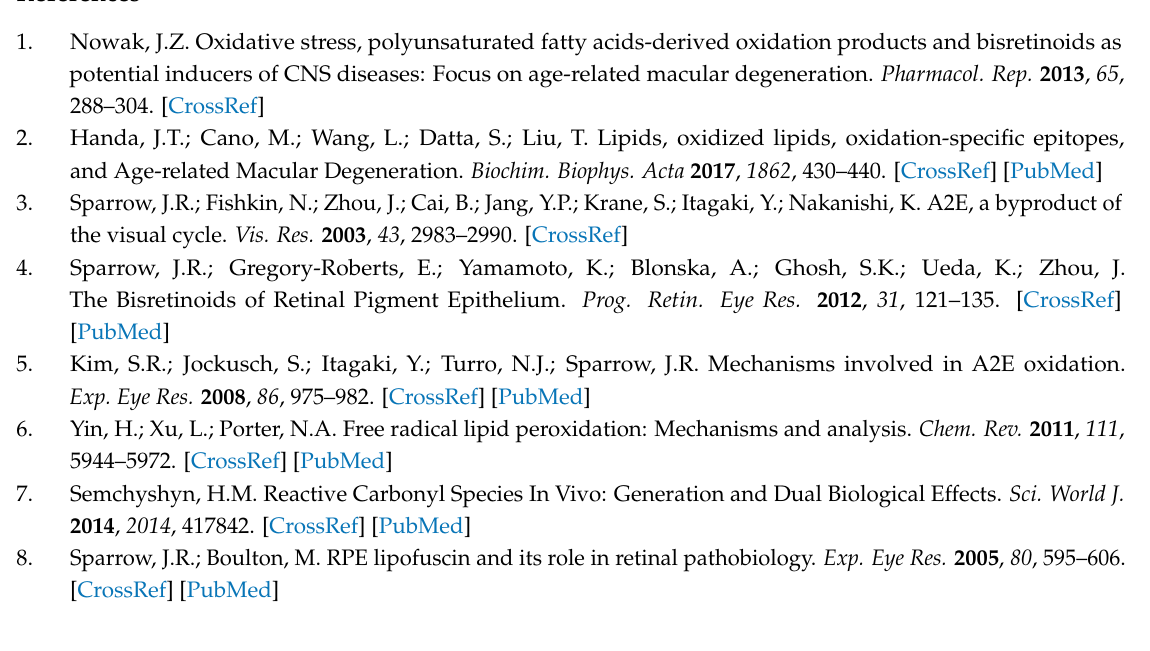
s1, Figure S1: Graphical representation of in vitro evaluations of lipophenols (toxicity and ROS inhibition), Experimental description of lipophenols synthesis and full NMR spectra characterization of derivatives from 2 to 18 ( 1 H and 13 C, Figure